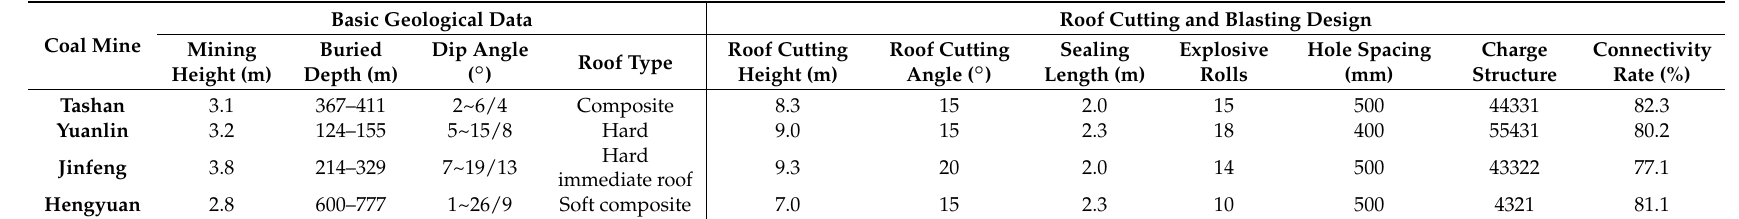
Table 5. Summary of the typical mine blasting